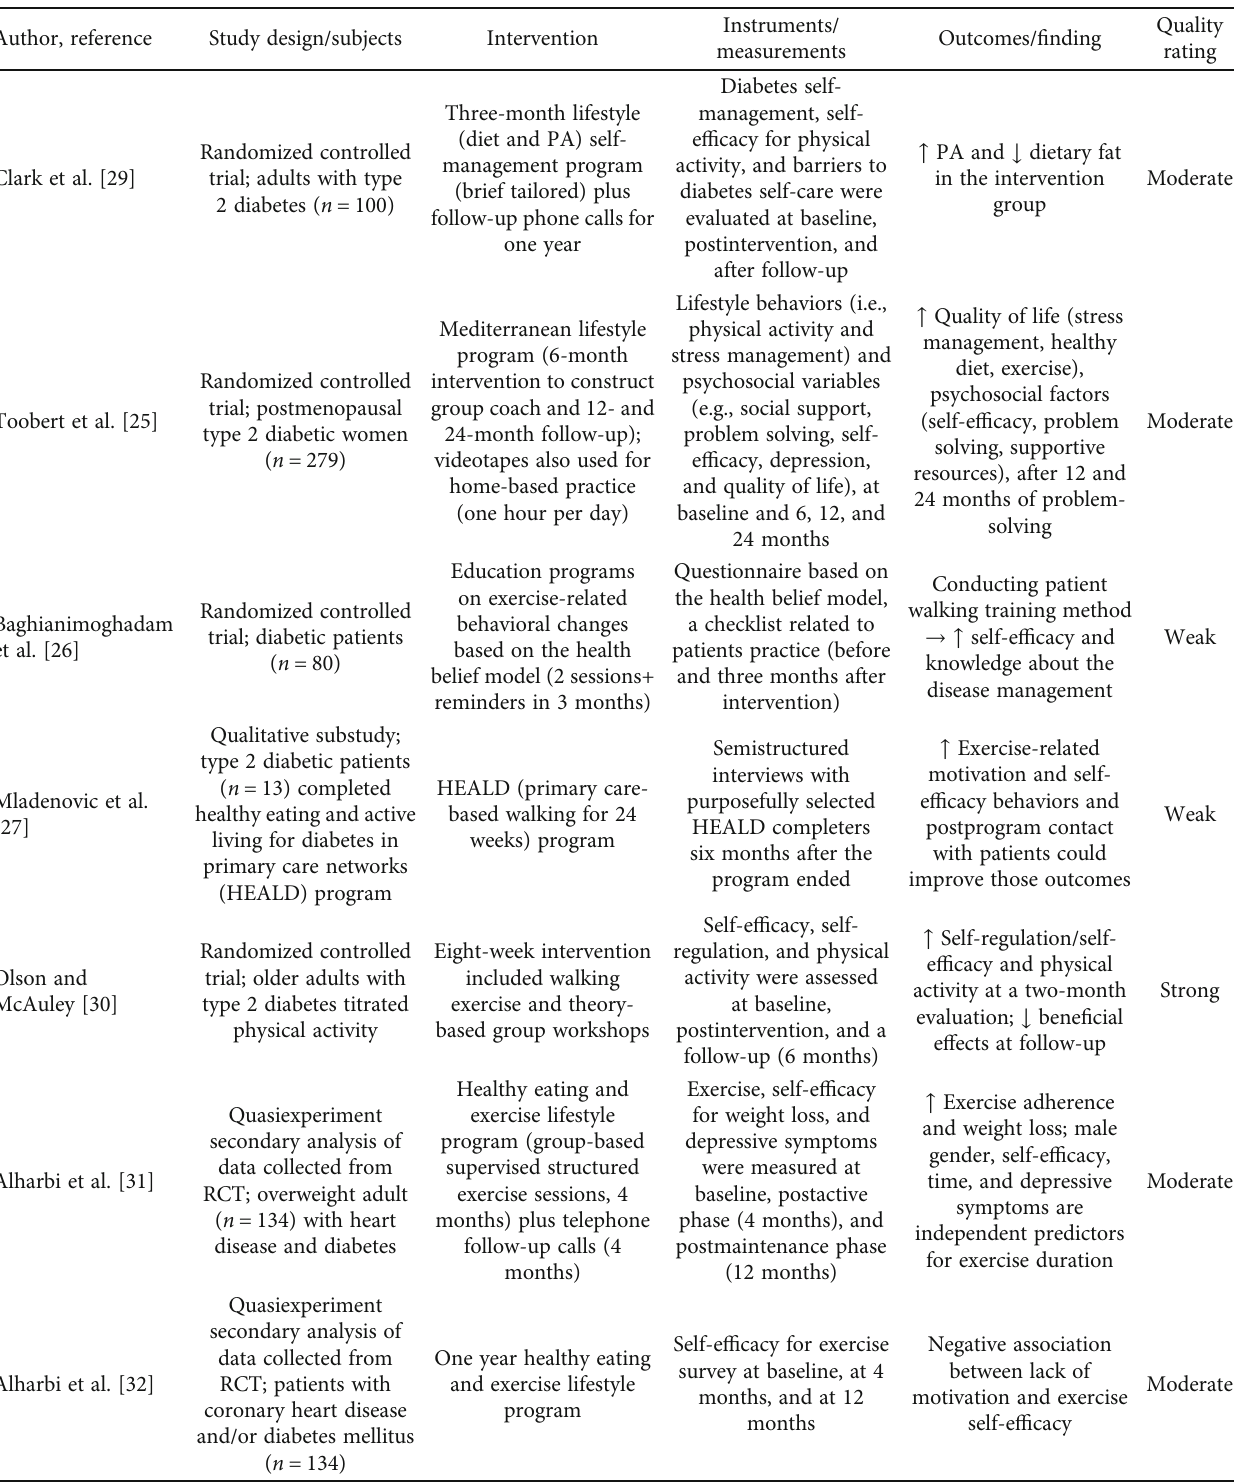
Table 3: Characteristics of studies using health promotion